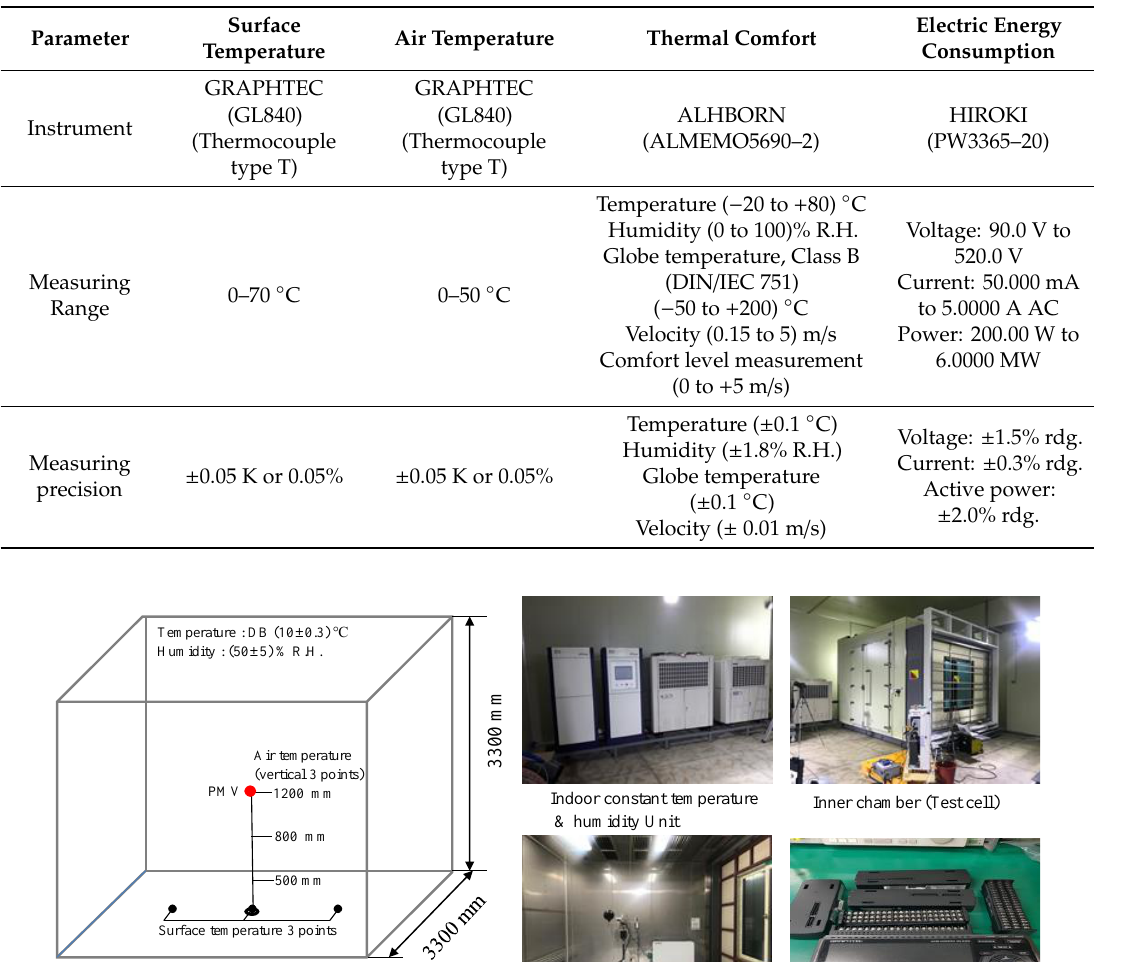
Table 3. Measuring instruments and measurement ranges.